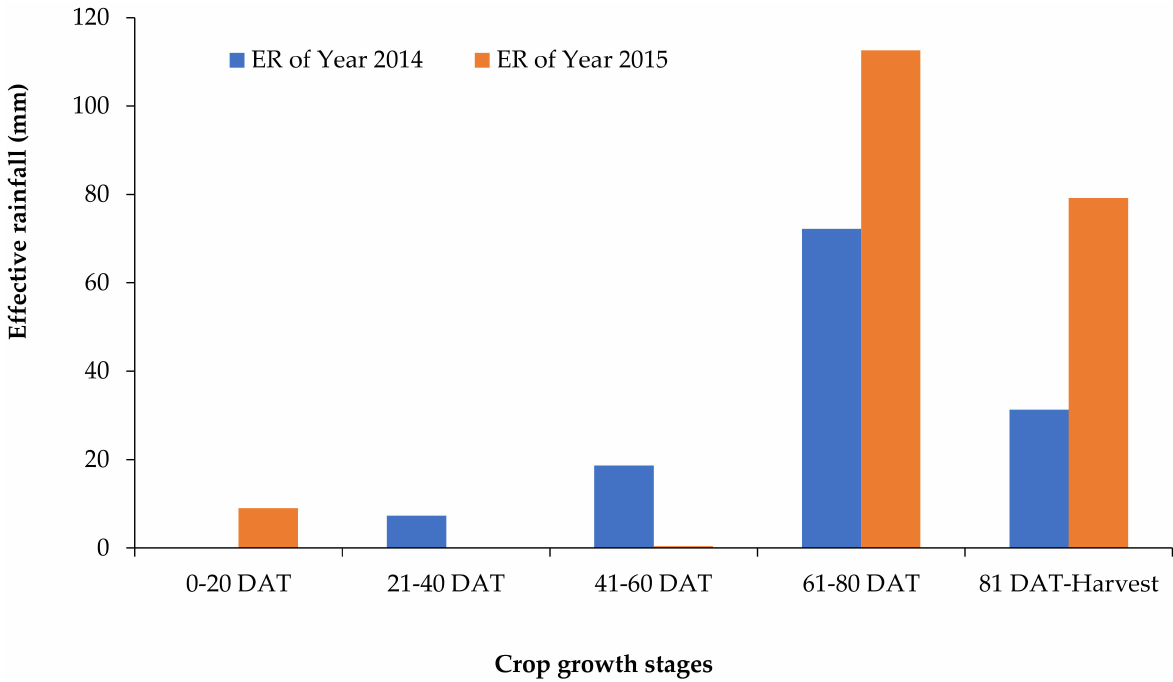
Figure 4. Crop growth stage-wise effective rainfall during 2014 and 2015; ER: Effective rainfall (mm); DAT: Days after